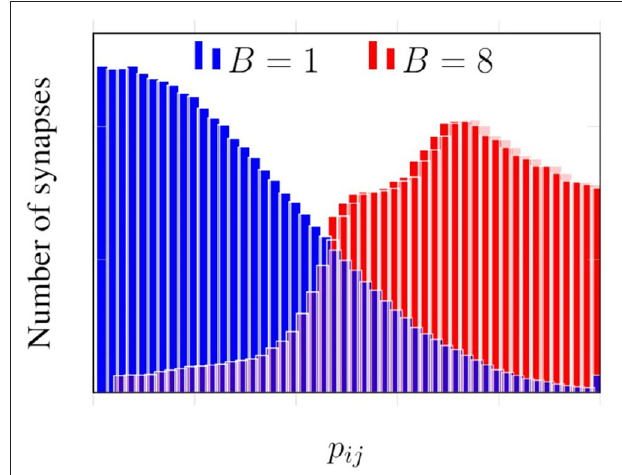
FIGURE 5 | Ratio of maximum to median outgoing weight.